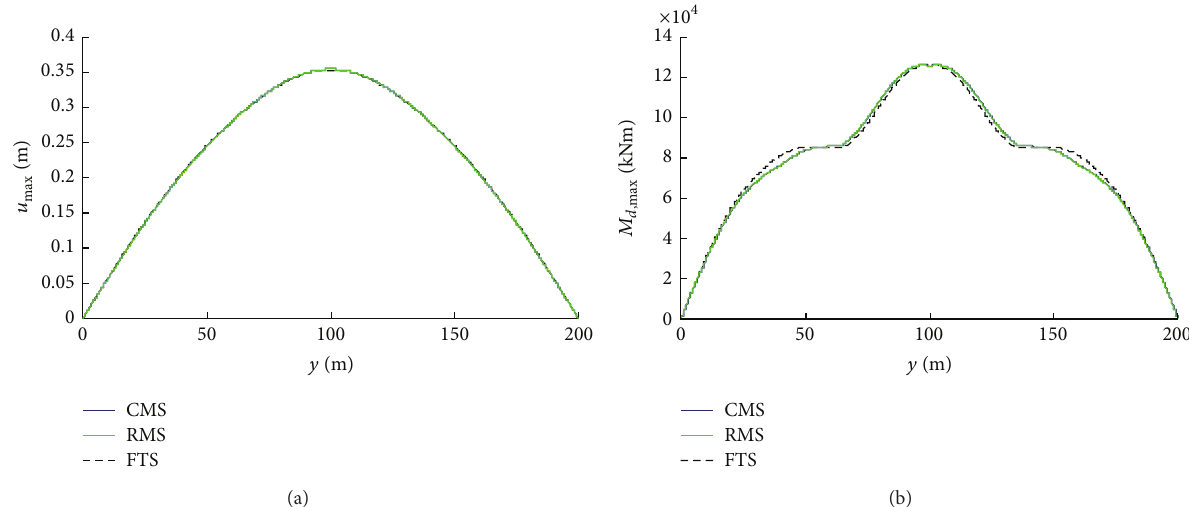
Figure 10: Transverse displacements 𝑢 max (a) and bending moments 𝑀 𝑑, max (b) along the deck according to the exact and the simplified analysis techniques. Table 3: Comparison of results (mean values and CoV of the response) according to the different analysis techniques. Response